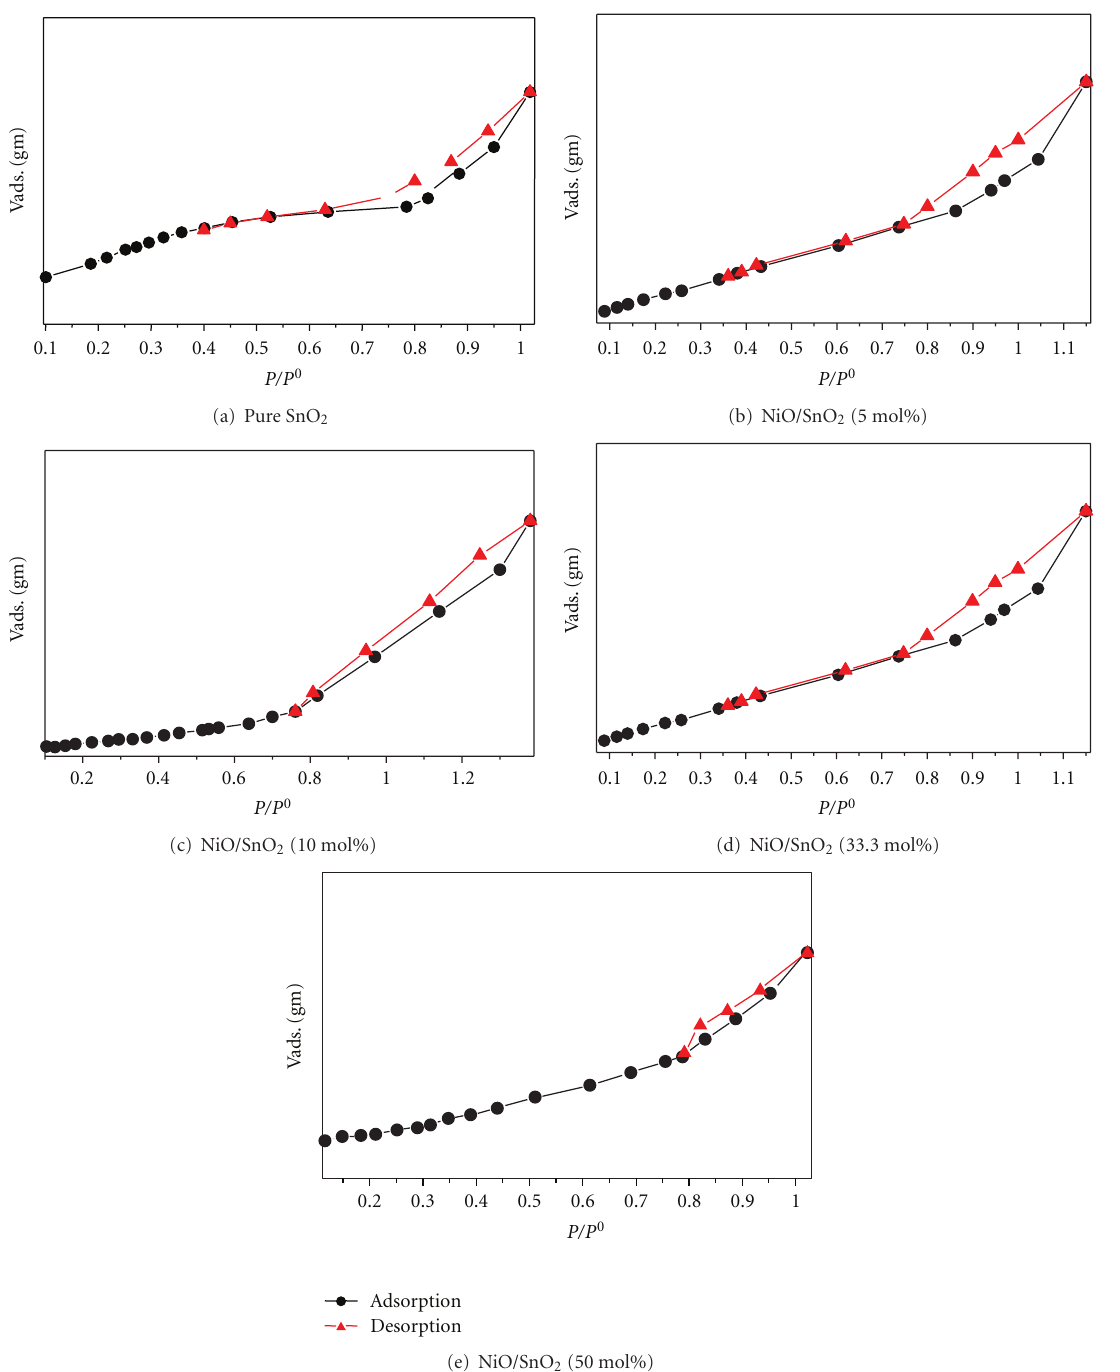
Figure 4: N 2 sorption isotherms of pure and nickel-doped SnO 2